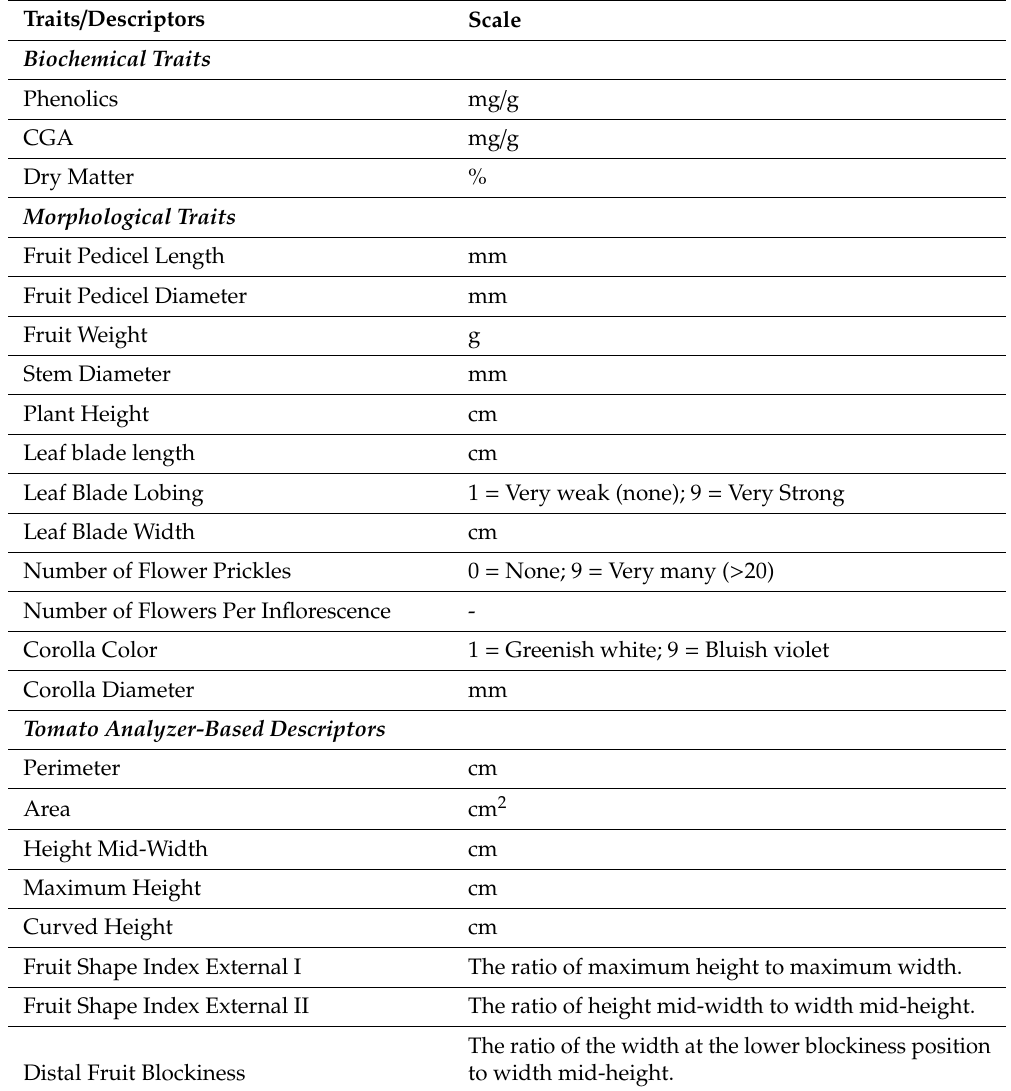
Table 2. List of di ff erent biochemical, morphological, and Tomato Analyzer-based traits / descriptors used for the